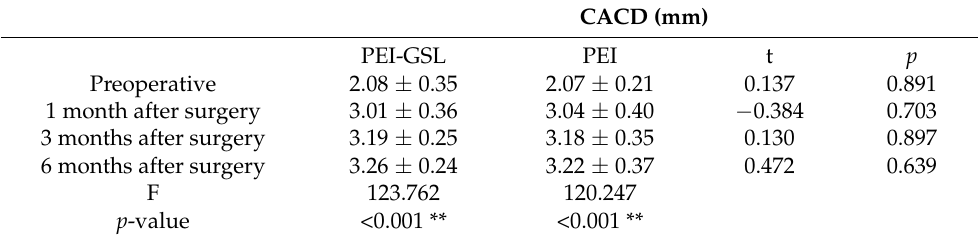
Table 4. Comparisons of CACD between PEI-GSL and PEI groups.